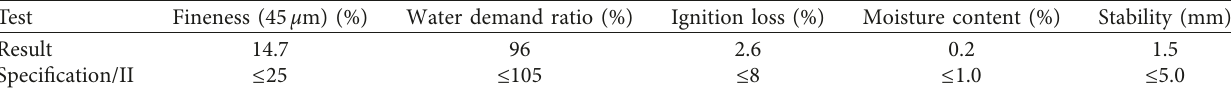
Table 2: Properties of fly